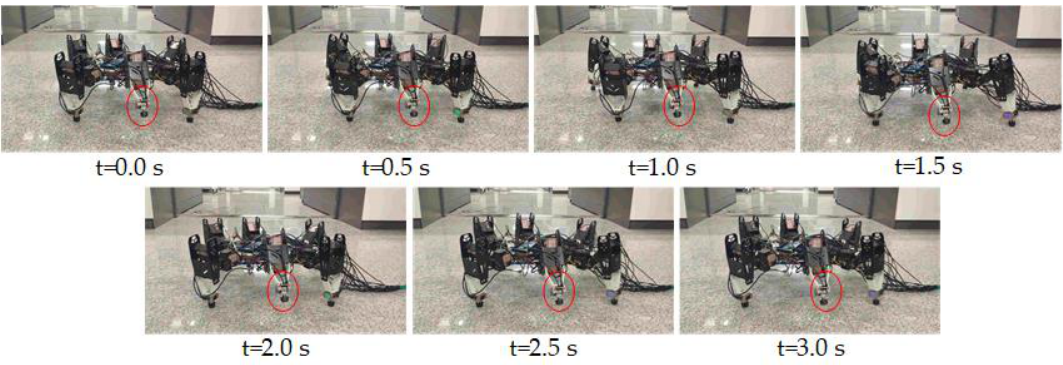
Pitch Roll Yaw Figure 26. The pitch, roll and yaw angle of the center of gravity (COG) in leg 1 failure experiment. 5.2.2. Experiment Results with Leg 2 Fault The experiment of the F-TT gait with leg 2 fault was also carried out. Figure 27 shows a set of snapshots of the walking experiment in the leg 2 failure, which show the motion state of the robot at